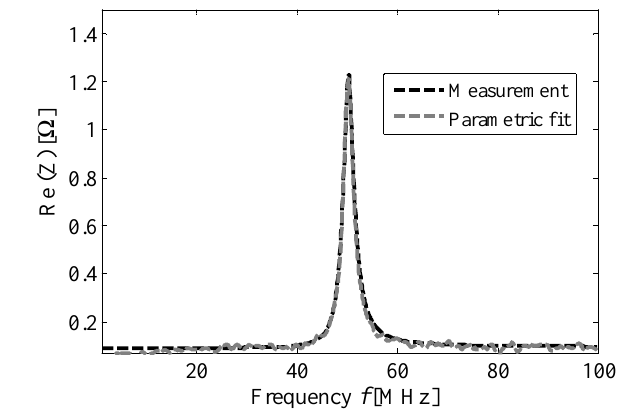
Figure 10. Wirelessly measured impedance real part and analytical fit for a micro coil with resonance frequency of 51.19MHz with an error of 0.41%.